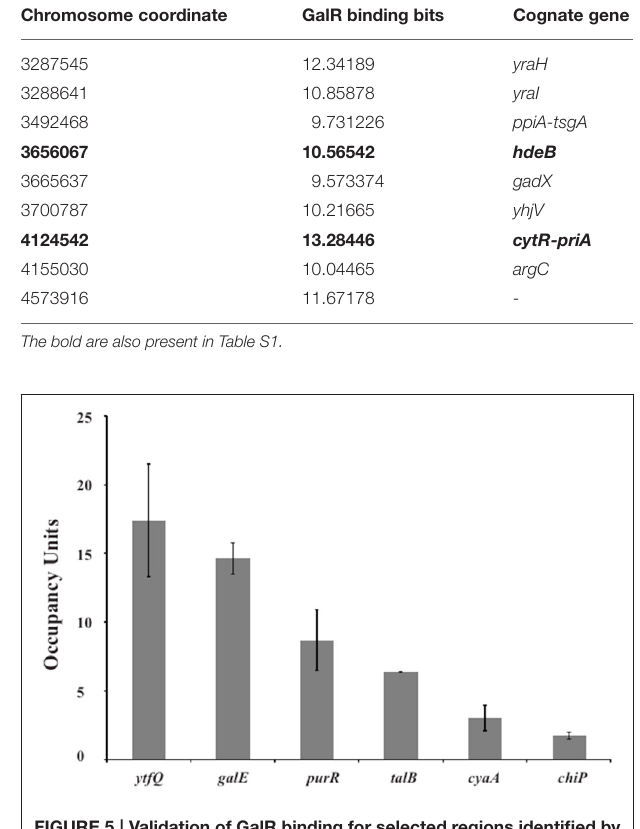
FIGURE 5 | Validation of GalR binding for selected regions identified by ChIP-chip. ChIP-qPCR measurements of GalR association with regions identified as putative GalR-bound regions by ChIP-chip, upstream of the indicated genes. Occupancy units represent background-subtracted enrichment relative to a control region within the transcriptionally inert bglB gene. Error bars indicate one standard deviation from the mean ( n =